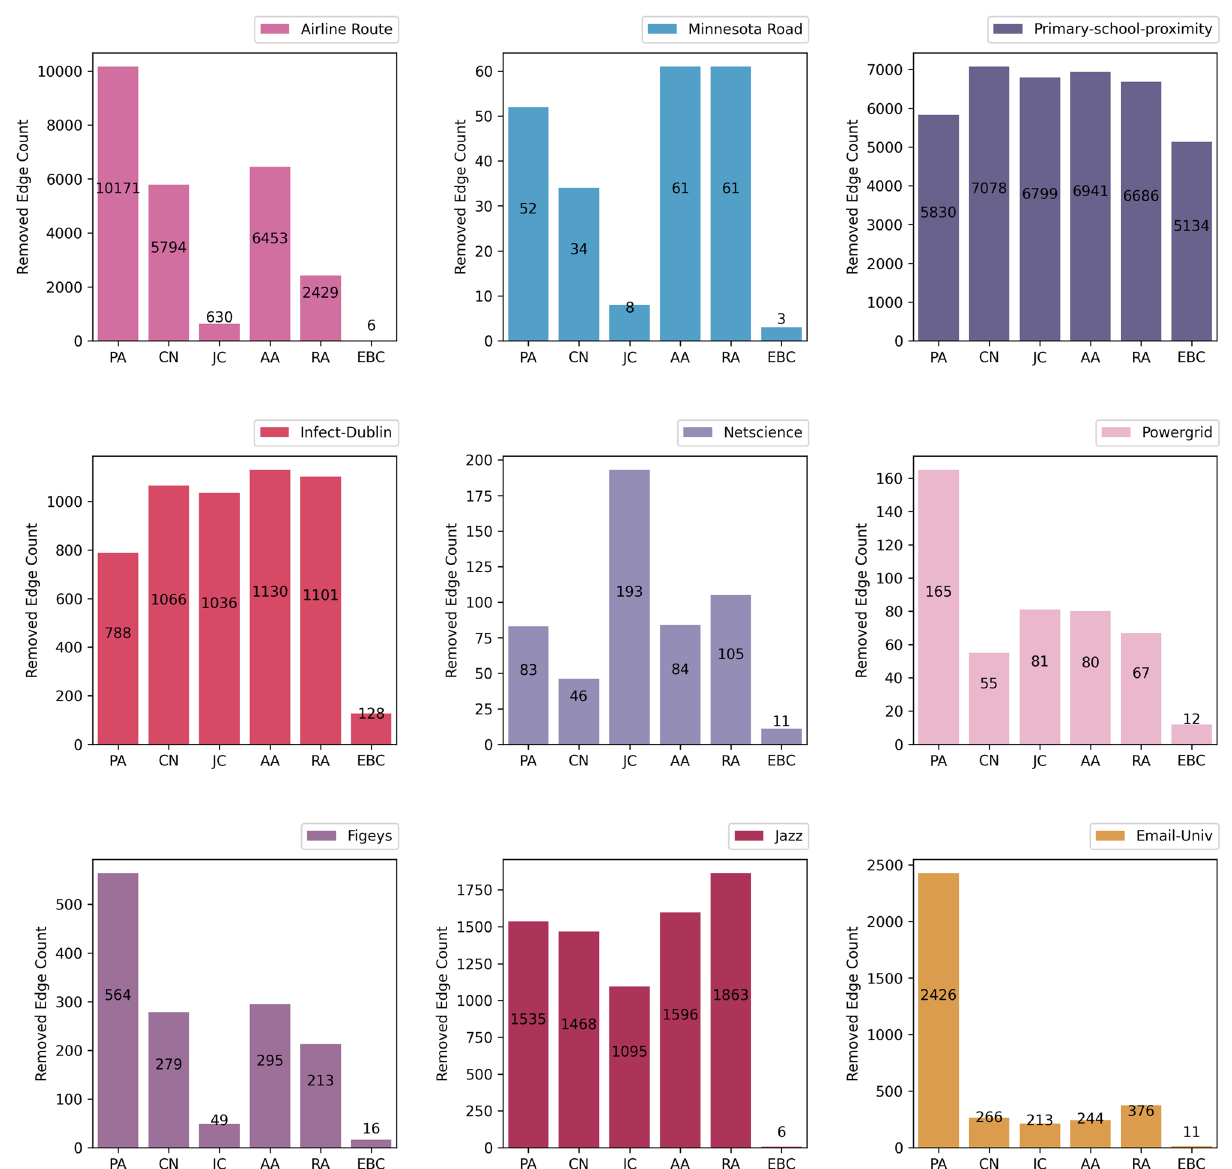
Figure 5. Threshold of disconnectivity over each dataset, maximum removals of edges for various RLP methods plus